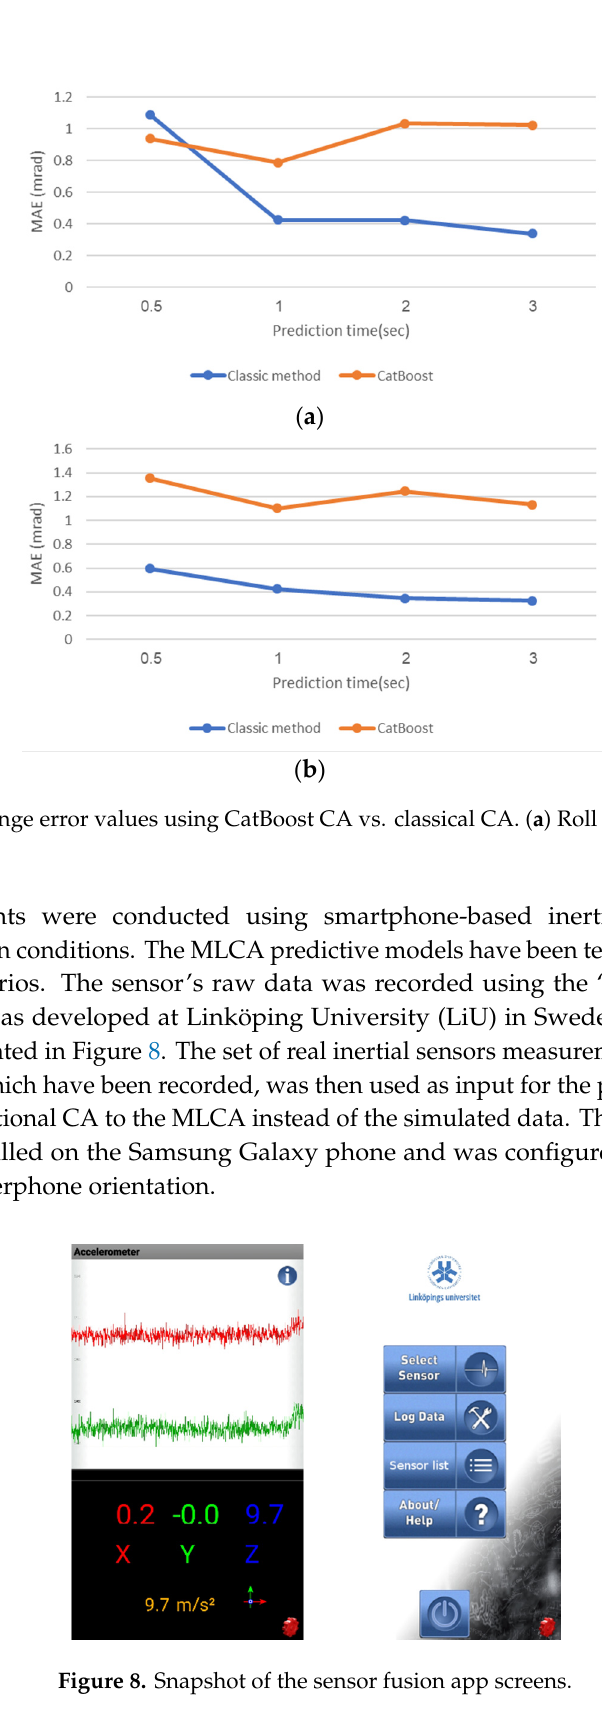
Figure 8. Snapshot of the sensor fusion app screens.